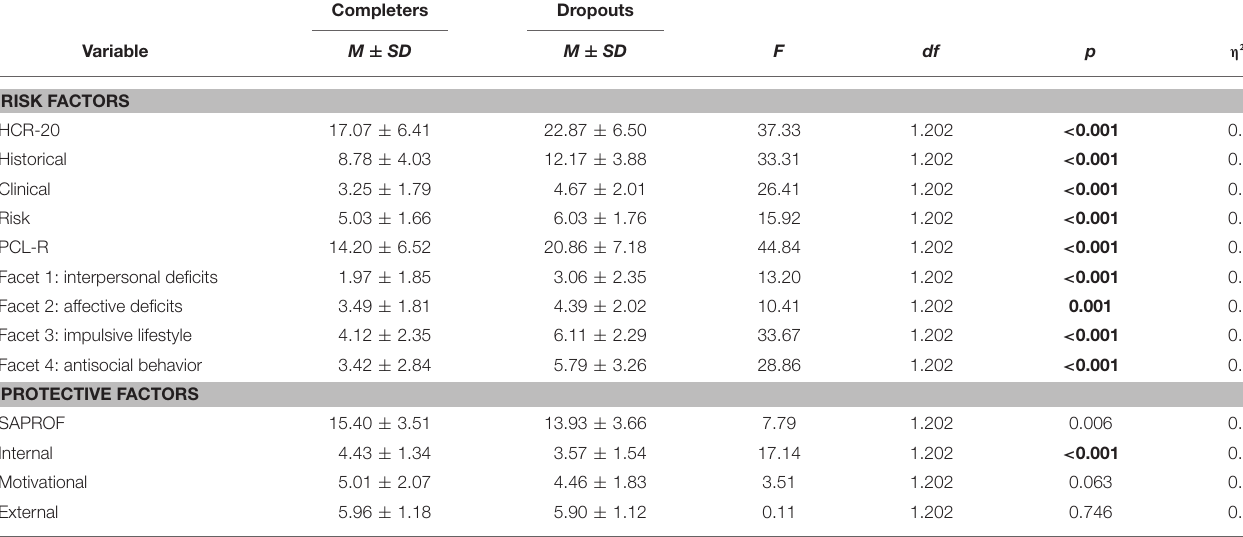
TABLE 3 | Comparisons of completers ( n = 134) and dropouts ( n = 70) regarding risk and protective factors. Completers